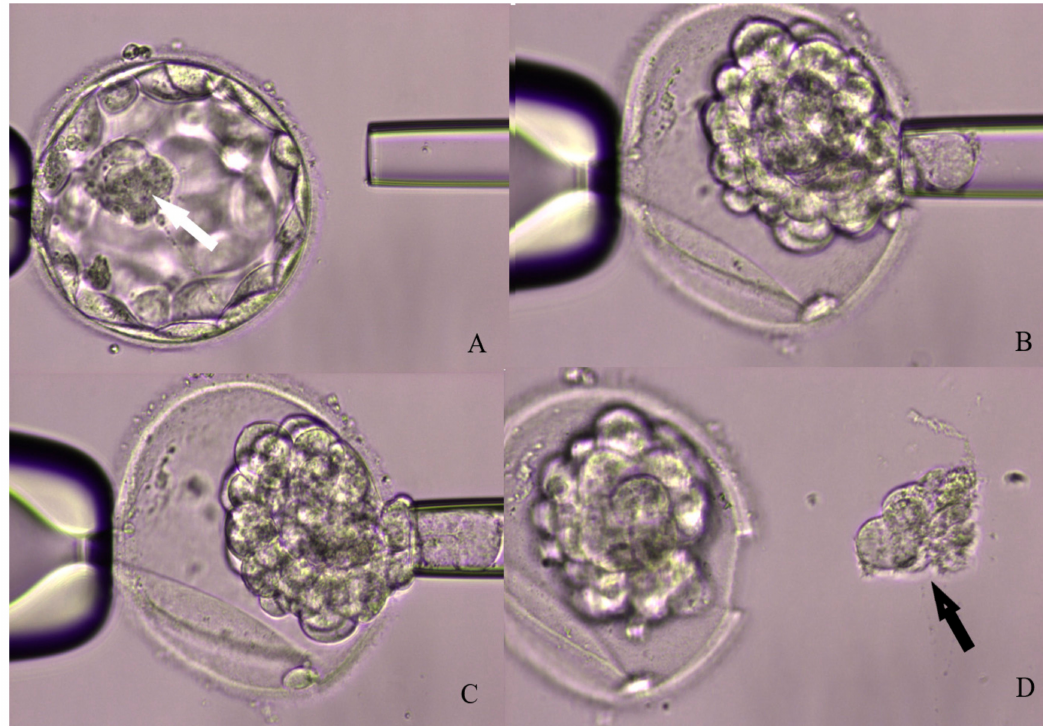
Figure 1. In the figure, the sequence of a blastocyst biopsy laser assisted is shown. The blastocyst is initially orientated by mean of the holding pipette in order to keep the inner cell mass as far as possible from the site of biopsy ( A ). Subsequently, the biopsy pipette is introduced through a hole performed with laser in the zona pellucida and a little number of trophectoderm cells are gently aspirated ( B , C ). Finally, the removed trophectoderm cells is transferred in a tube for the genetic analysis ( D ). The white narrow indicates the inner cell mass. The black narrow indicates the removed trophectoderm